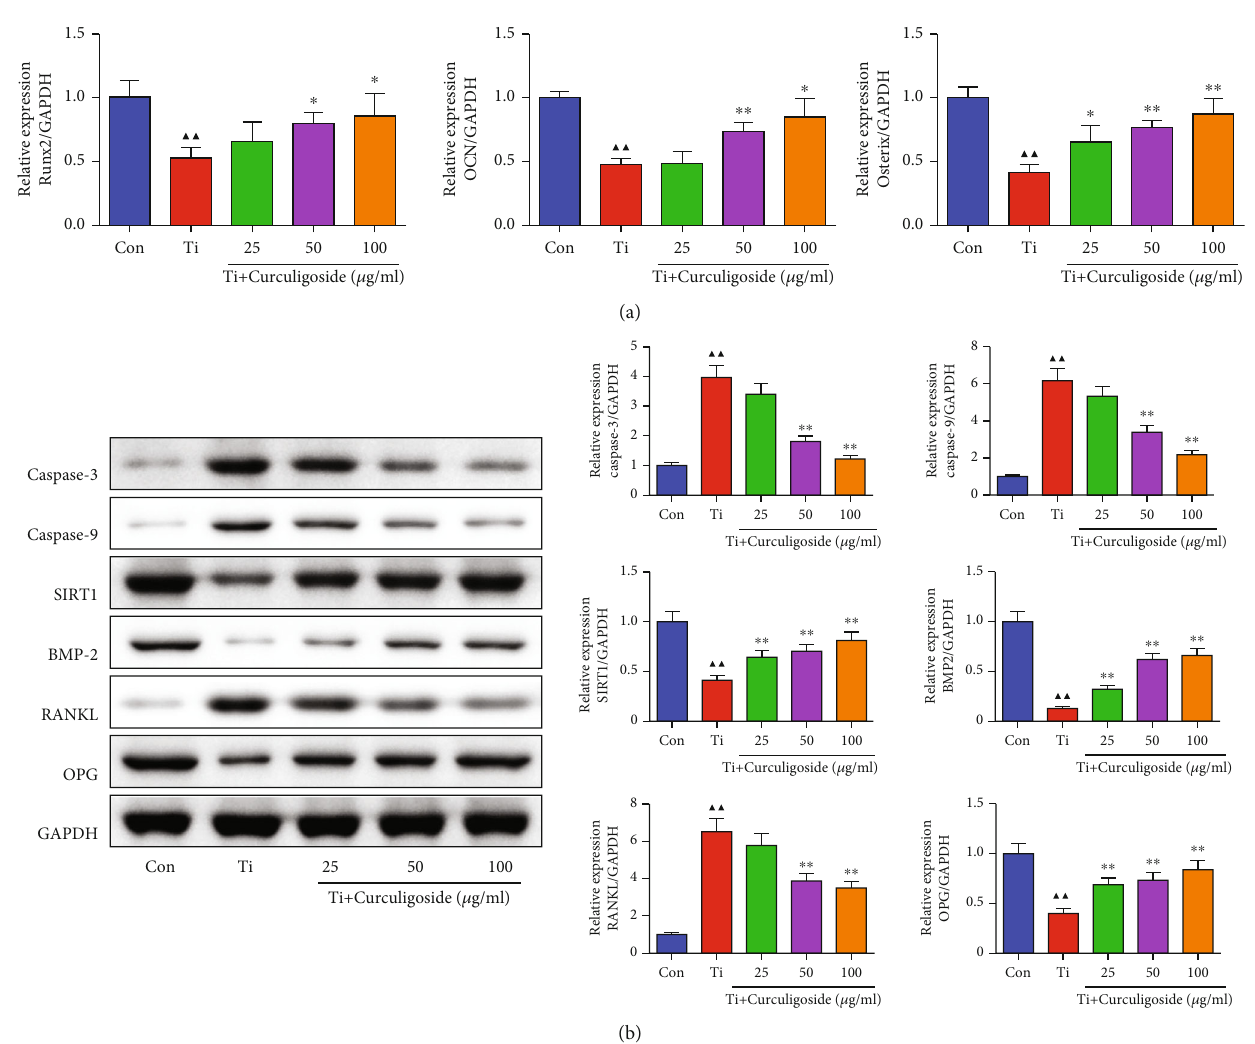
Figure 4: Curculigoside treatment promoted the osteogenic-associated gene expression in Ti-induced in MC3T3-E1 cells. (a) qRT-PCR analysis was performed to detect the relative mRNA expression of Runx2, osterix, and OCN in MC3T3-E1 cells. (b) Western blot analysis was performed to detect the relative protein expression of casepase-3, casepase-9, SIRT1, BMP-2, RANKL, and OPG in MC3T3-E1 cells ( n = 3 ); results are represented as the mean ± SD . ▲ P < 0 : 05 , compared to the Con group; ▲▲ P < 0 : 01 , compared to the Con group; ∗ P < 0 : 05 , compared to the Ti group; ∗∗ P < 0 : 01 , compared to the Ti group. Ti: titanium particle; Con: